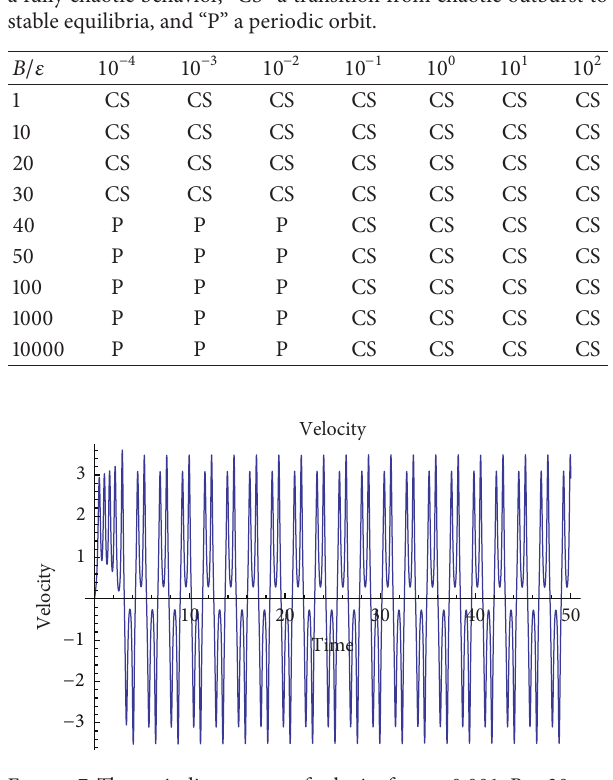
Figure 7: The periodic progress of velocity for 𝜀 = 0.001, 𝐵 = 30, ] = 0